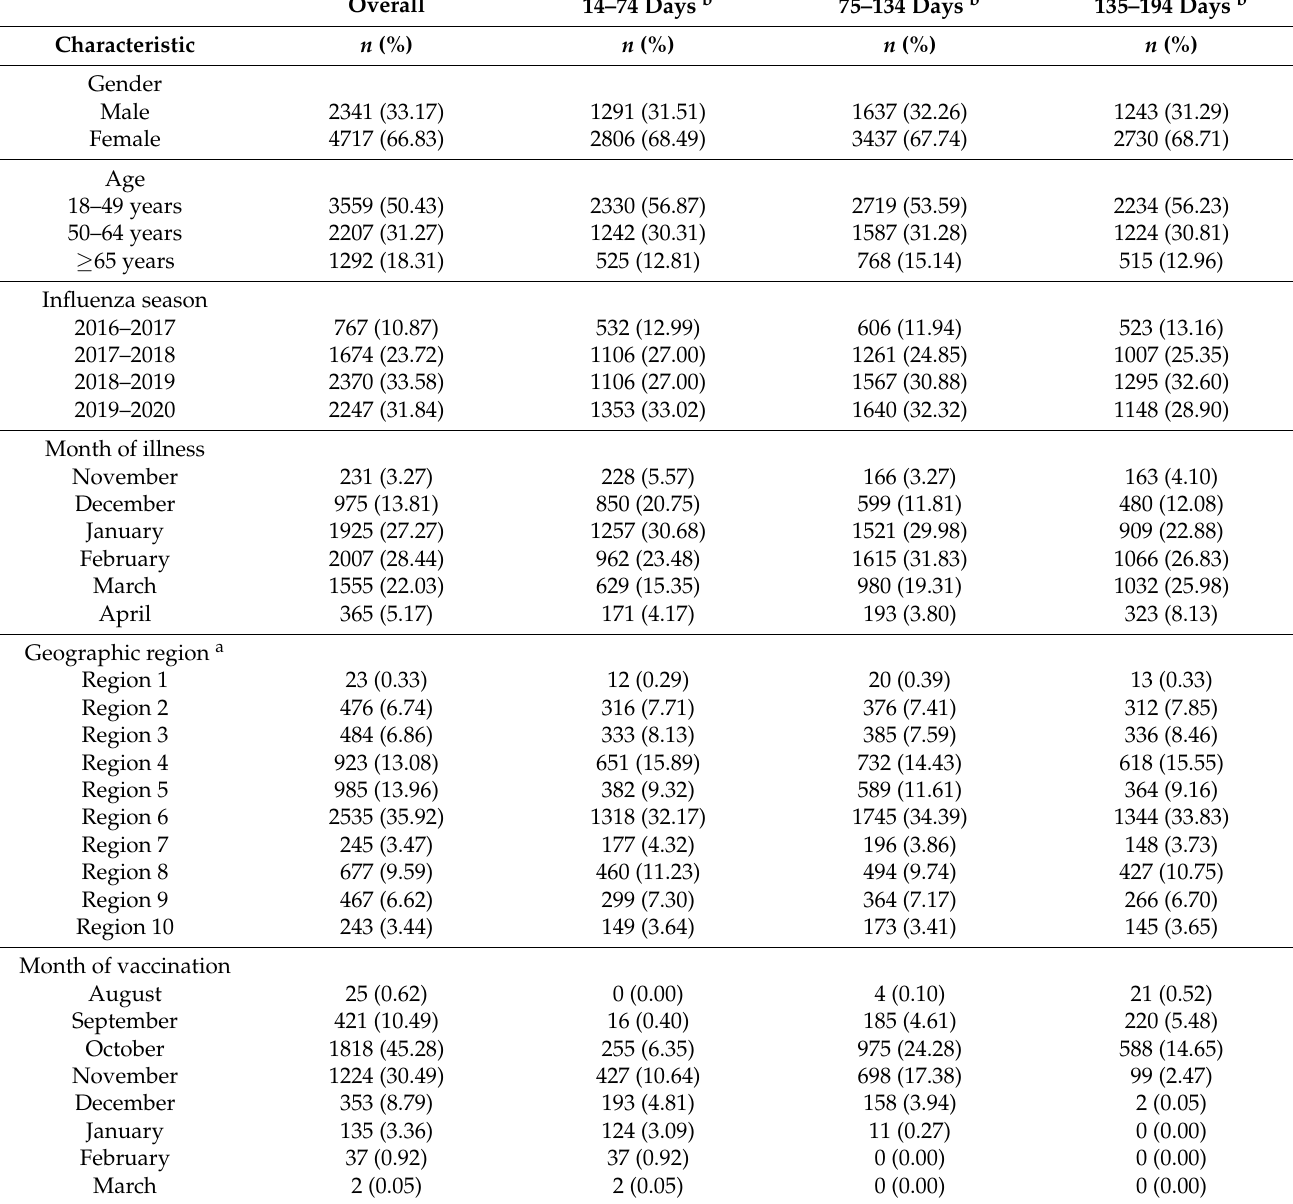
Table 1. Characteristics of the study population used for vaccine effectiveness